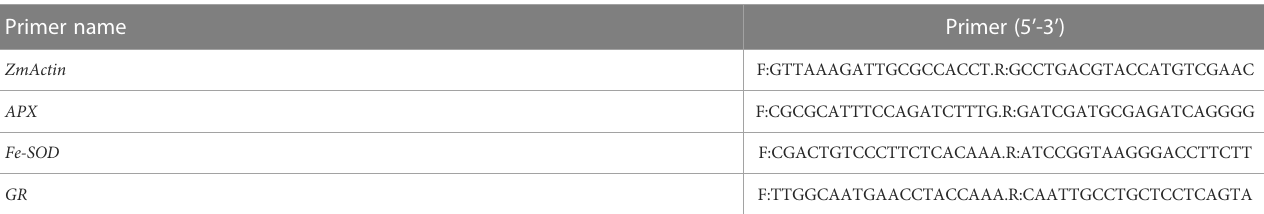
TABLE 1 Primers used real-time fl uorescence quantitative PCR.